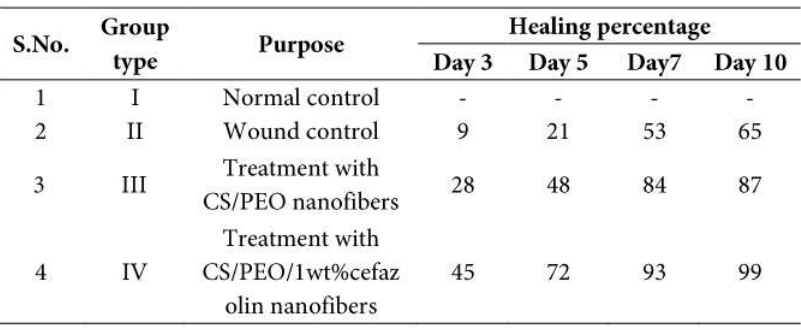
Table 2. The results of in vivo testing of